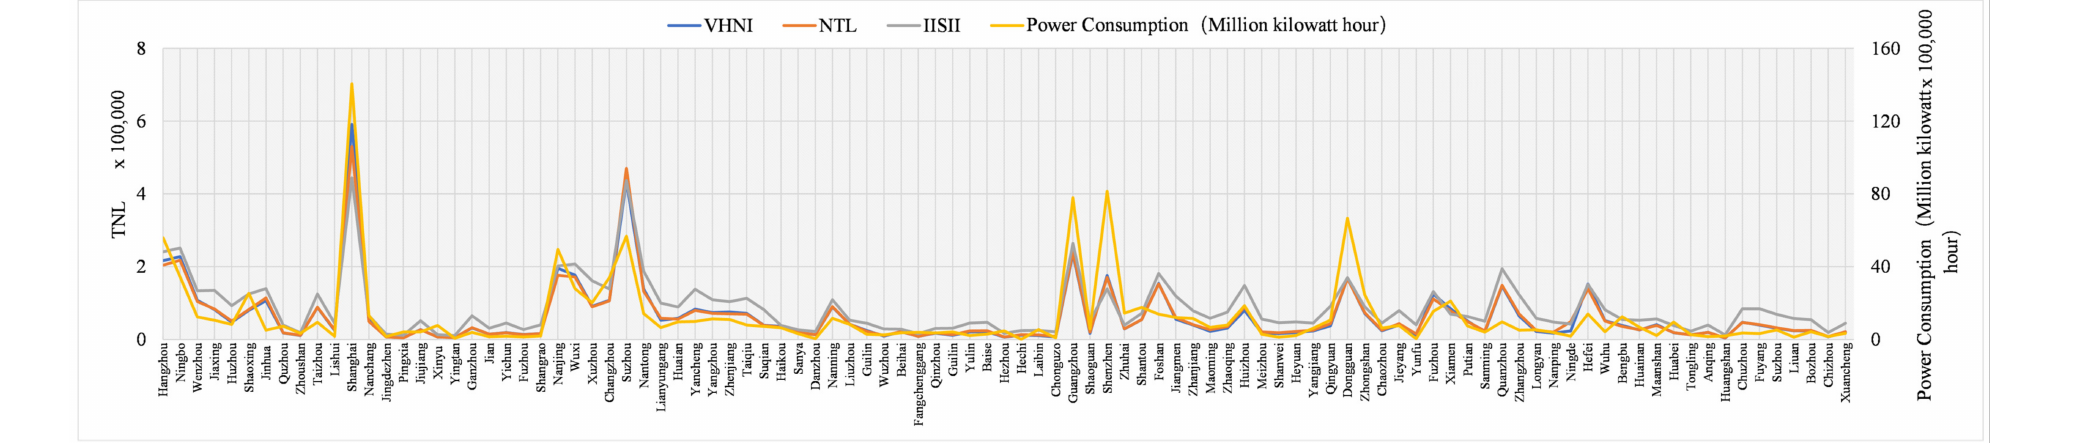
Figure 4. TNL of different indices and power consumption at municipal